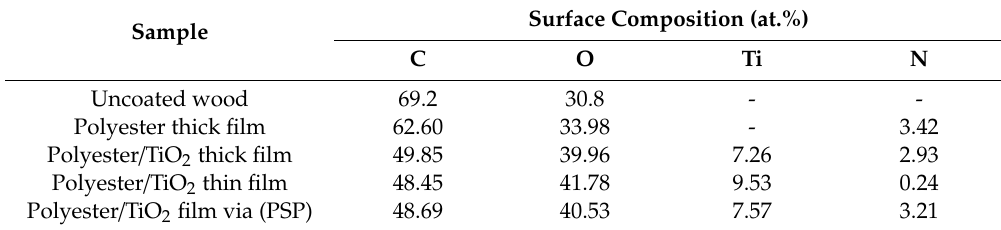
Table 3. Surface composition of di ff erent coatings observed in the XPS